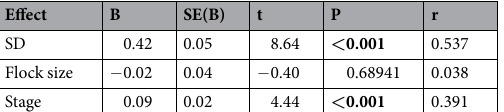
Table 1. Results of a phylogenetic generalized least square regression (PGLS) model testing for among-stage differences in flight initiation distance (FID) after accounting for the confounding effects of starting distance (SD) and flock size as well as for phylogenetic ( λ = 0.476; χ 2 112 = 12.89; P = < 0.001) and sample size (V + 20 W) effects. Model statistics are F 4,112 = 31.77, P < 0.001, R 2 = 0.45, AIC = − 132.4. Boldface indicates statistical significance, and Pearson r values effect sizes.